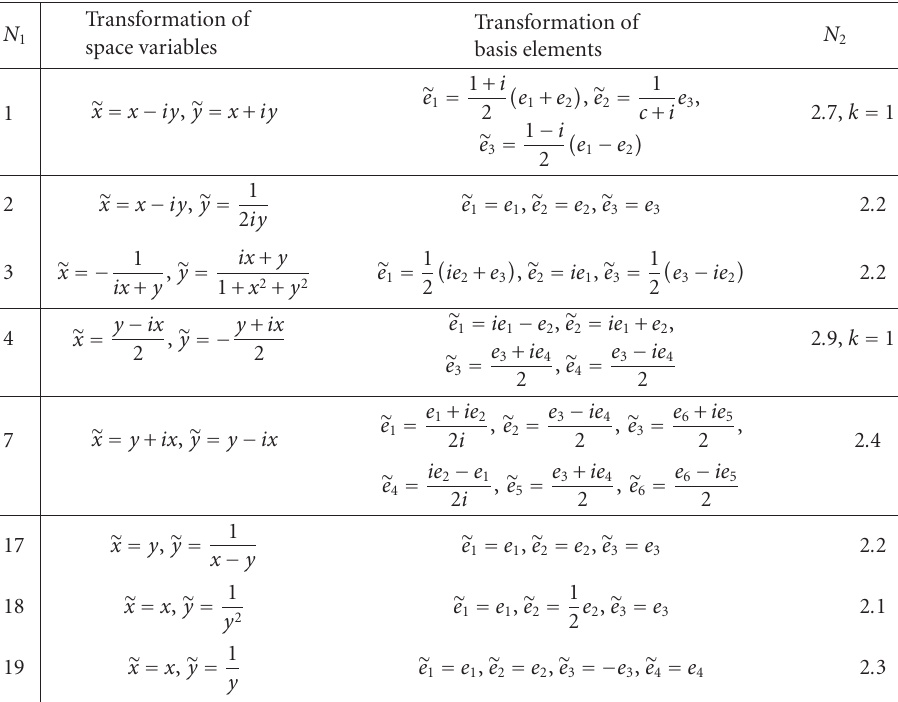
Table 1.2. Transformations of real realizations to complex